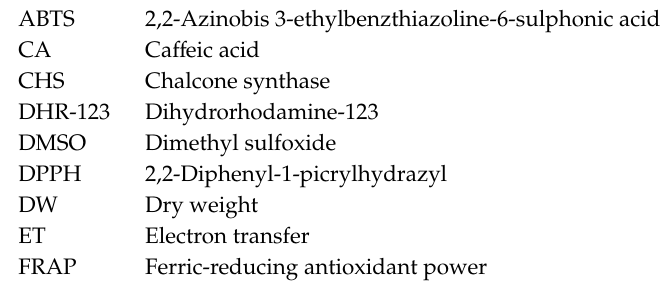
Supplementary Materials: The following are available online: Figure S1: Loading scores of the first axis of the principal component analysis showing the impact of melatonin (MEL), UV-C (UV) and their combination on the phytochemical and antioxidant capacities of purple basil calli extracts. Figure S2: Loading scores of the second axis of the principal component analysis showing the impact of melatonin (MEL), UV-C (UV) and their combination on the phytochemical and antioxidant capacities of purple basil calli